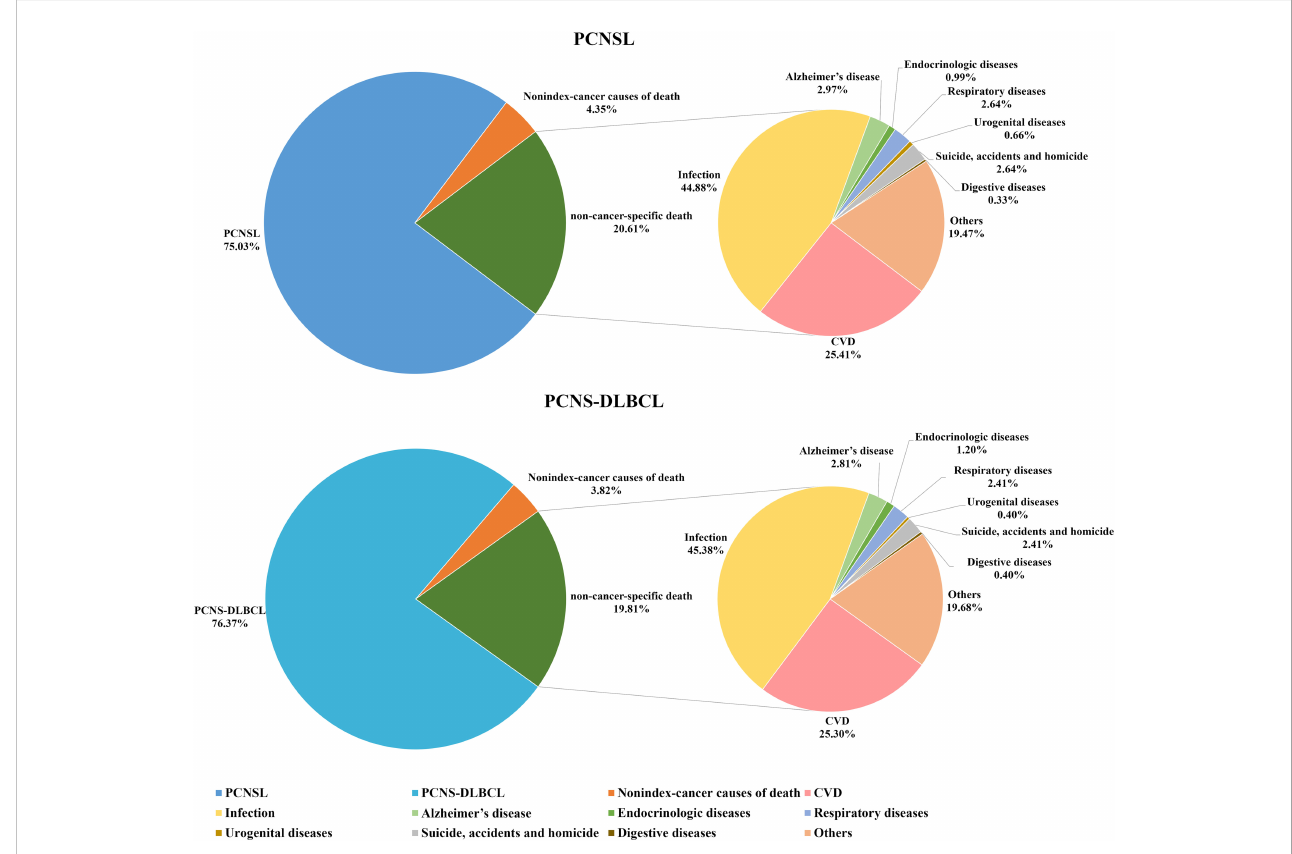
FIGURE 1 Proportions of deaths in patients with PCNSL and PCNS-DLBCL. PCNSL, primary central nervous system lymphoma; PCNS-DLBCL, primary central nervous system diffuse large B-cell